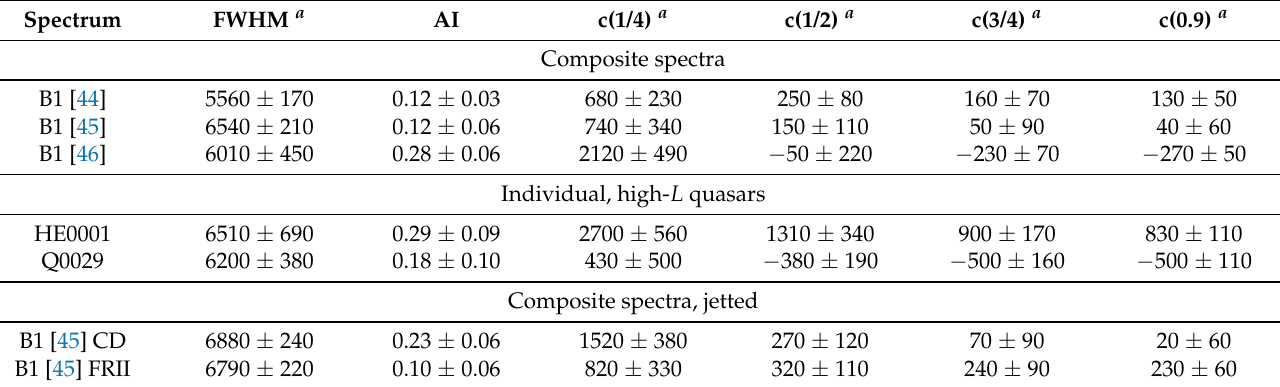
Table 3. H β profile properties